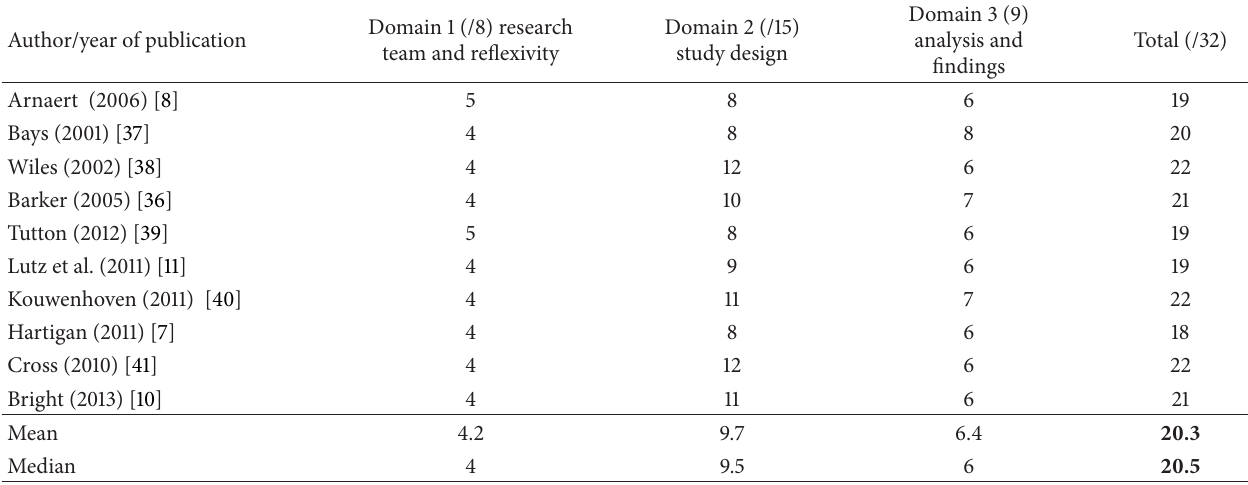
Table 2: The summary of correctly scored domains of the COREQ (Tong et al., 2007) [34] appraisal for the 4 included